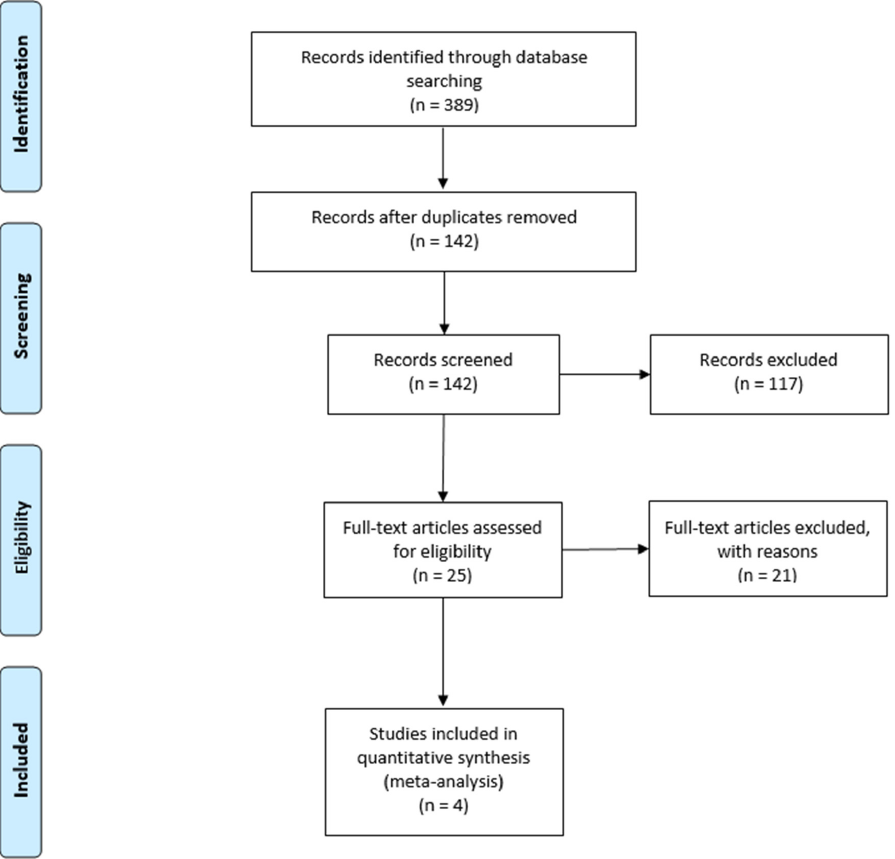
Figure 2. Flow diagram of search for eligible studies.